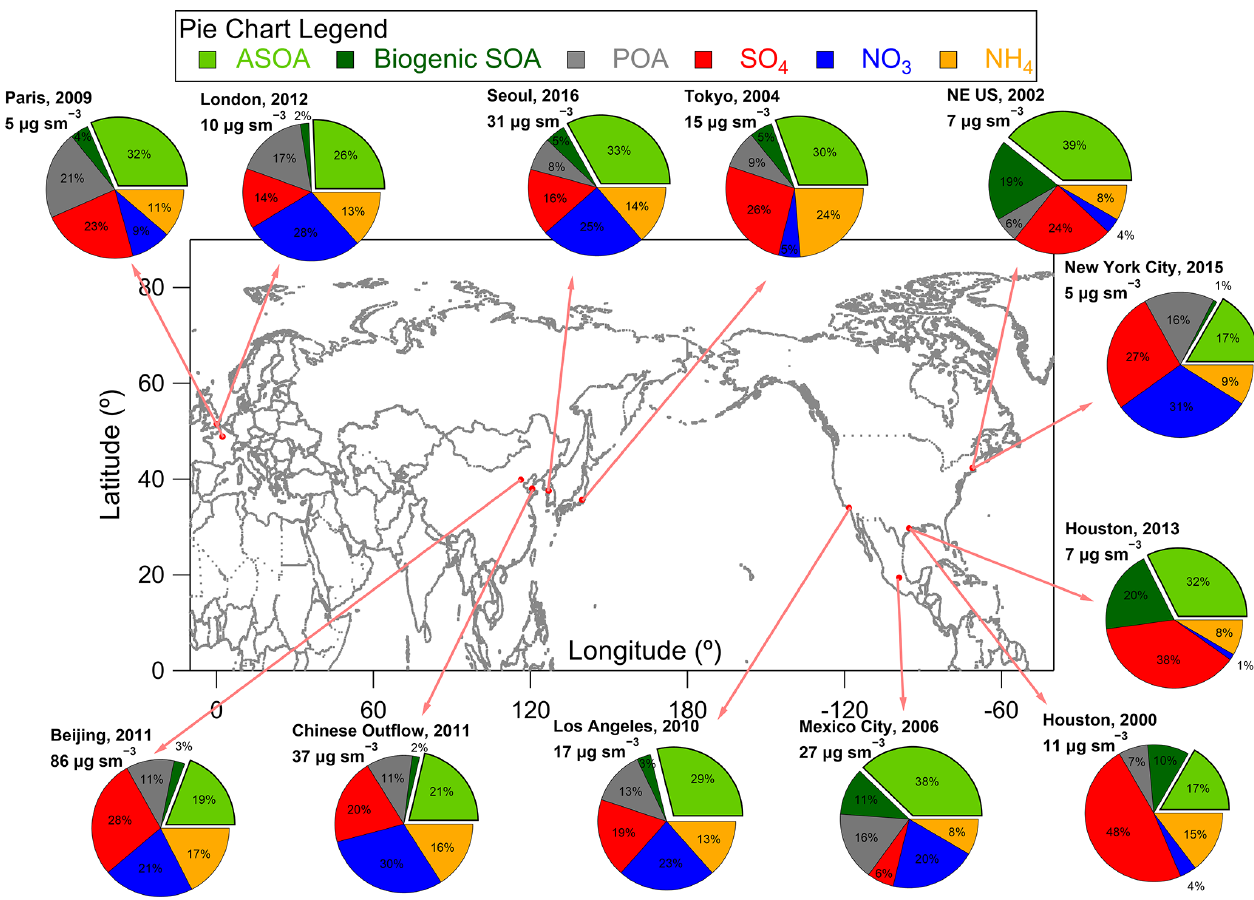
Figure 1. Non-refractory submicron aerosol composition measured in urban and urban outflow regions from field campaigns used in this study (all in units of µgm − 3 ) at standard temperature (273K) and pressure (1013hPa) (sm − 3 ). See Sect. S3 and Table 1 for further informa- tion on measurements, studies, and apportionment of SOA into ASOA and